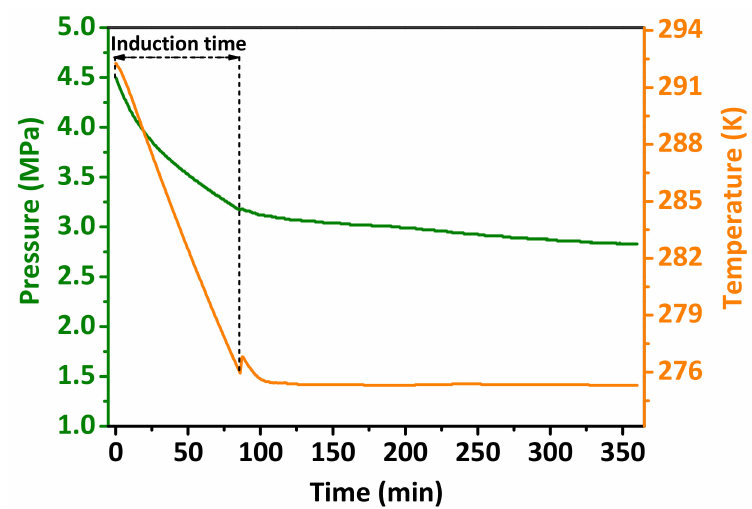
Figure 6. Pressure and temperature profiles of the hydrate formation